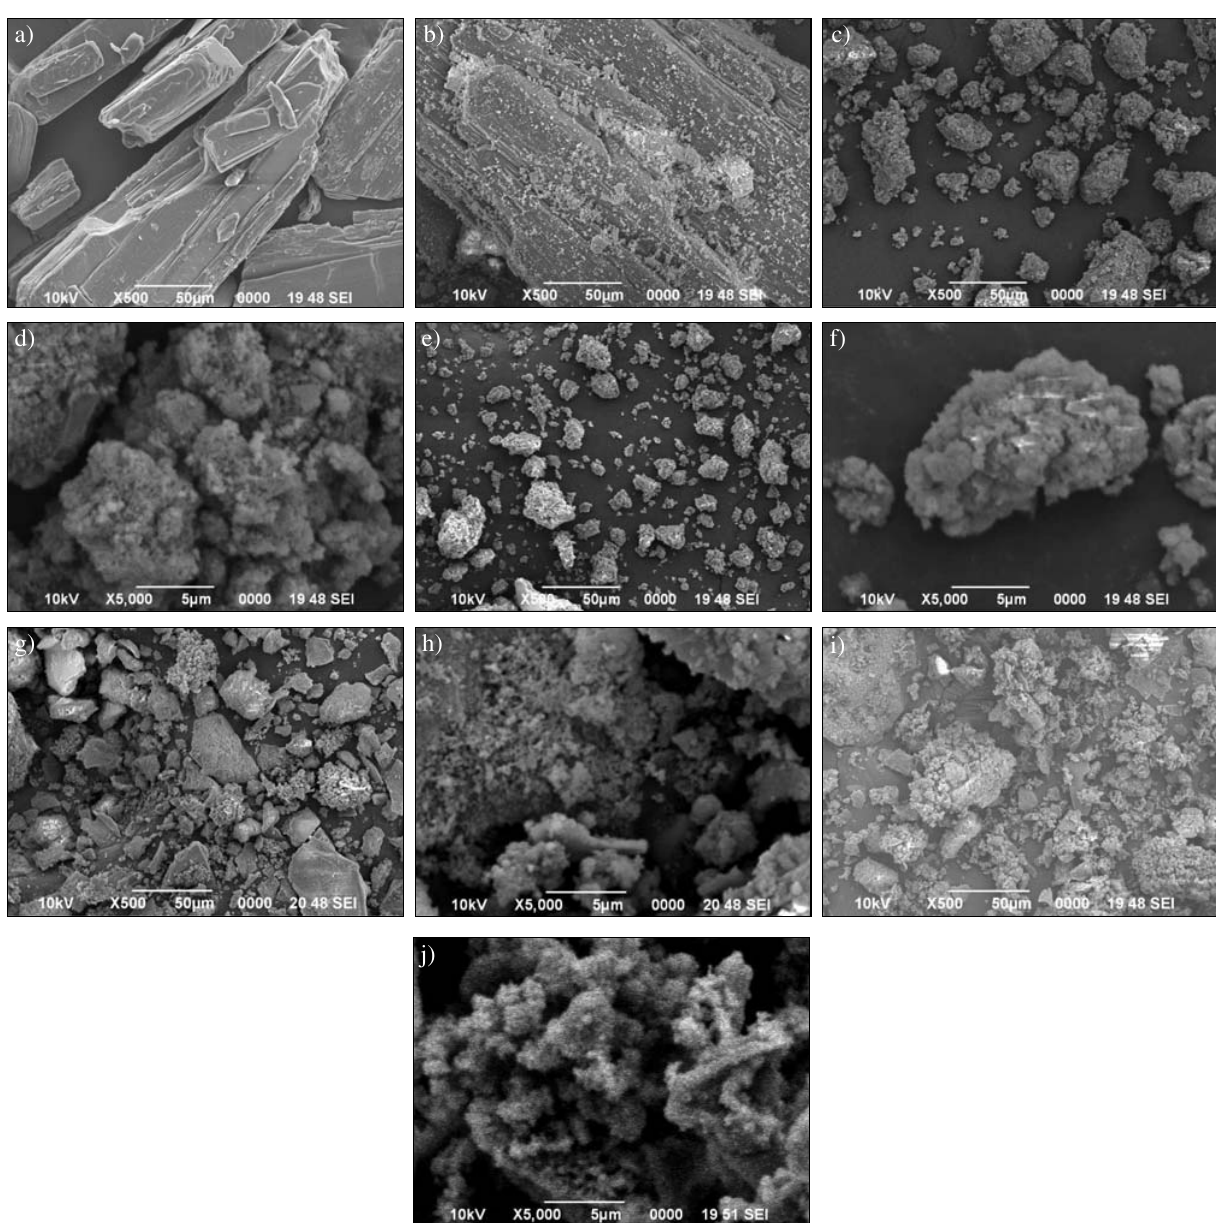
Figure 2. (a) Ibuprofen pure, (b) IB (X500), (h)